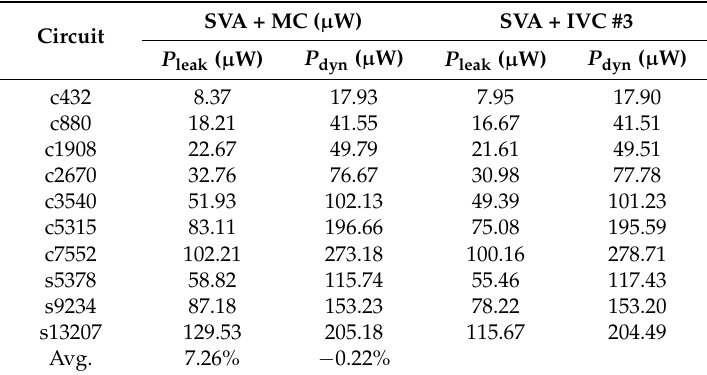
Table 9. Leakage and dynamic power of SVA using an input vector found by Monte Carlo (MC) simulation and the IVC #3 method.